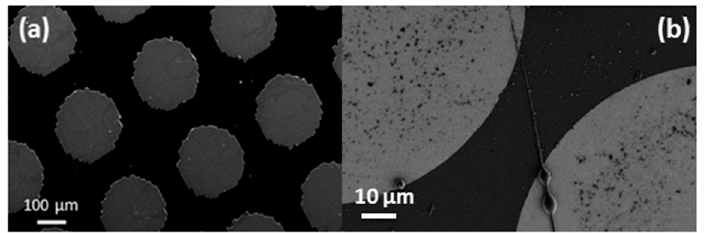
Figure 3. SEM images: ( a ) Cu microelectrodes array; ( b ) Aligned nanofiber between two electrodes.